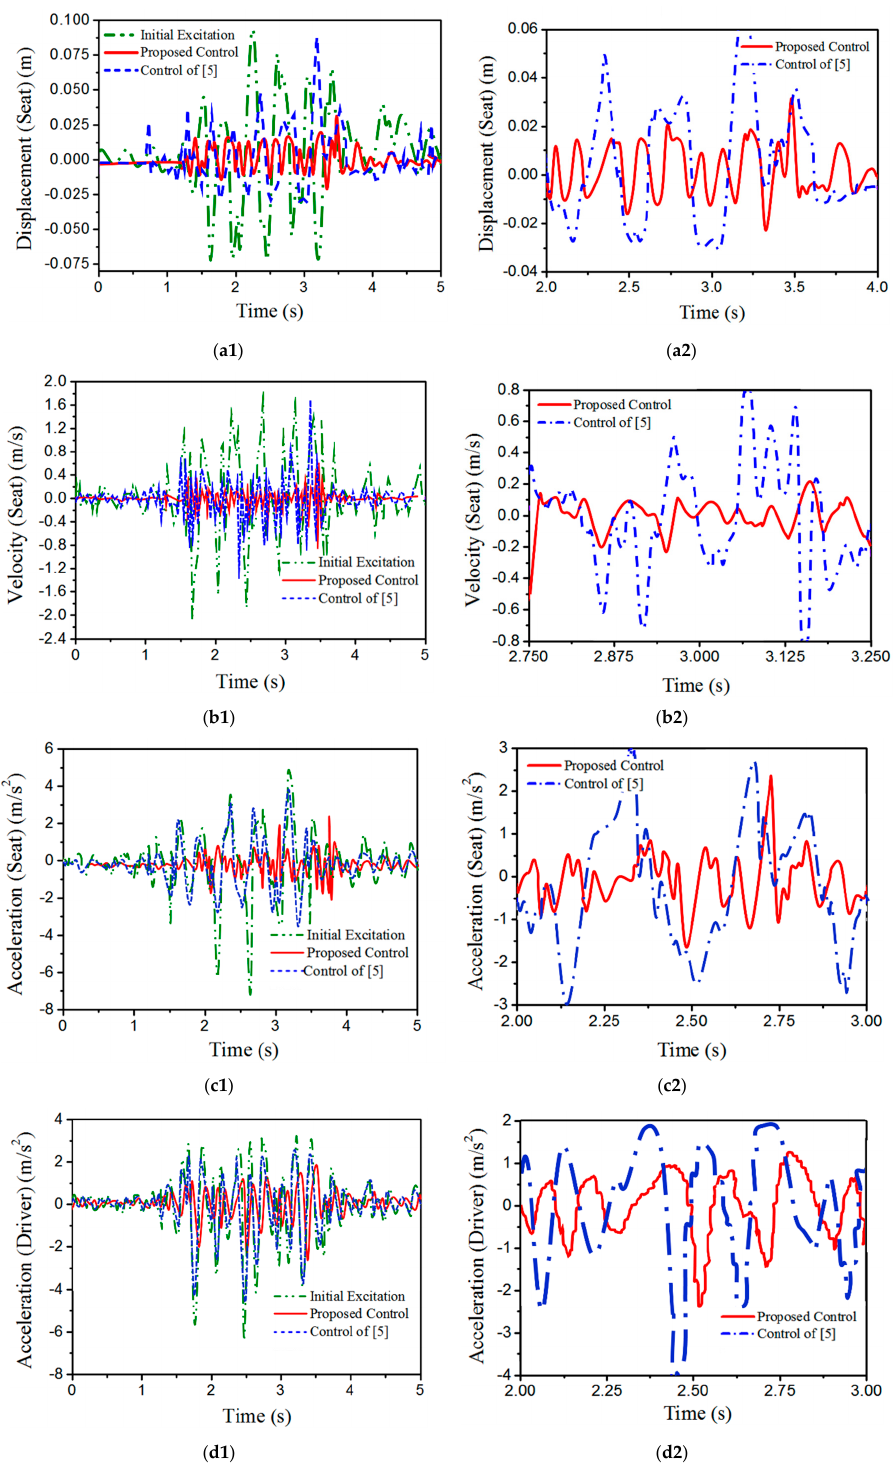
Figure 8. Experiment results under random-step-wave excitation: ( a1 ) displacement; ( a2 ) enlarged view of the displacement; ( b1 ) velocity; ( b2 ) enlarged view of the velocity; ( c1 ) acceleration at the seat; ( c2 ) enlarged view of the acceleration at the seat; ( d1 ) acceleration of the driver; ( d2 ) enlarged view of the acceleration of the driver.